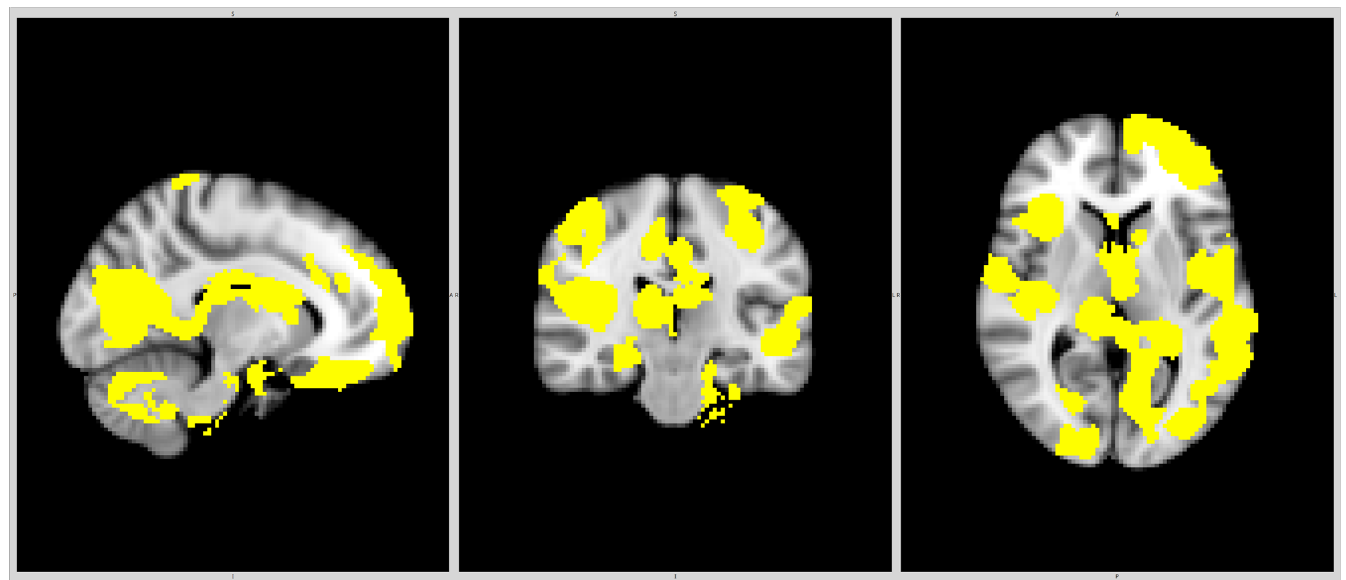
Fig 1. Regional brain volumes reduced in clinically isolated syndrome compared to controls.